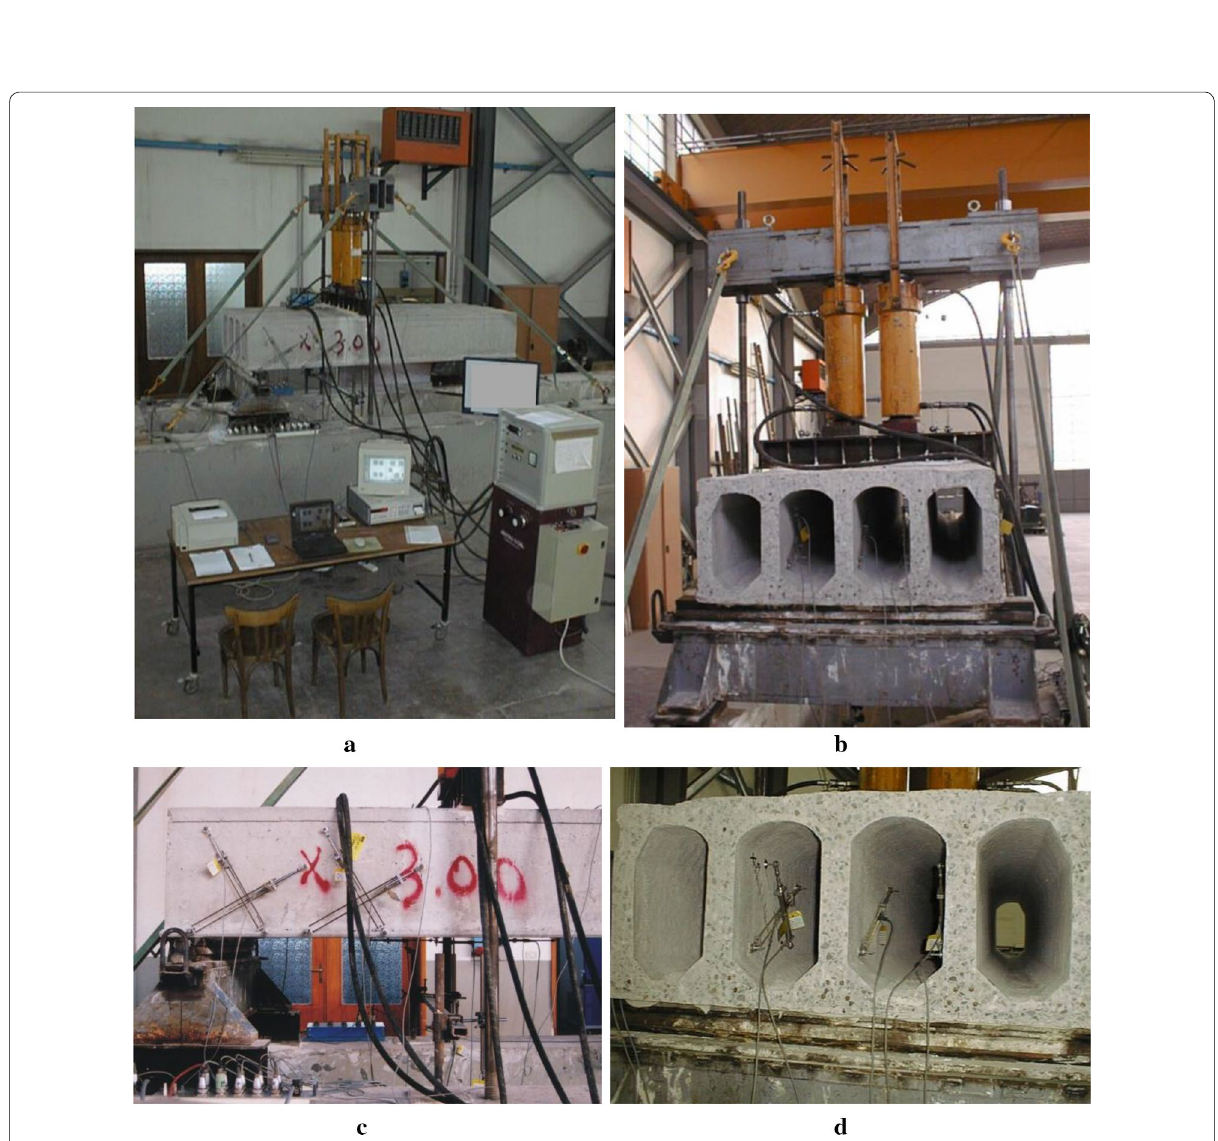
Fig. 7 Shear tests on specimens H50-s1 and H50-s2: a , b general view of the experimental setup; details of the adopted instrumentations; c view of LVDTs arrangement on HCS; d LVDTs arrangement inside